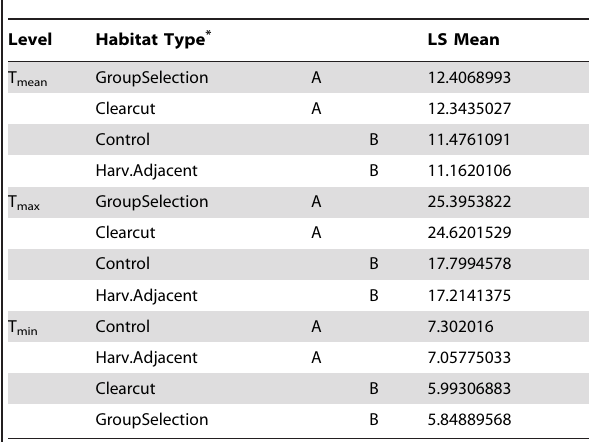
*Habitat types at each level not connected by the same letter are significantly different.